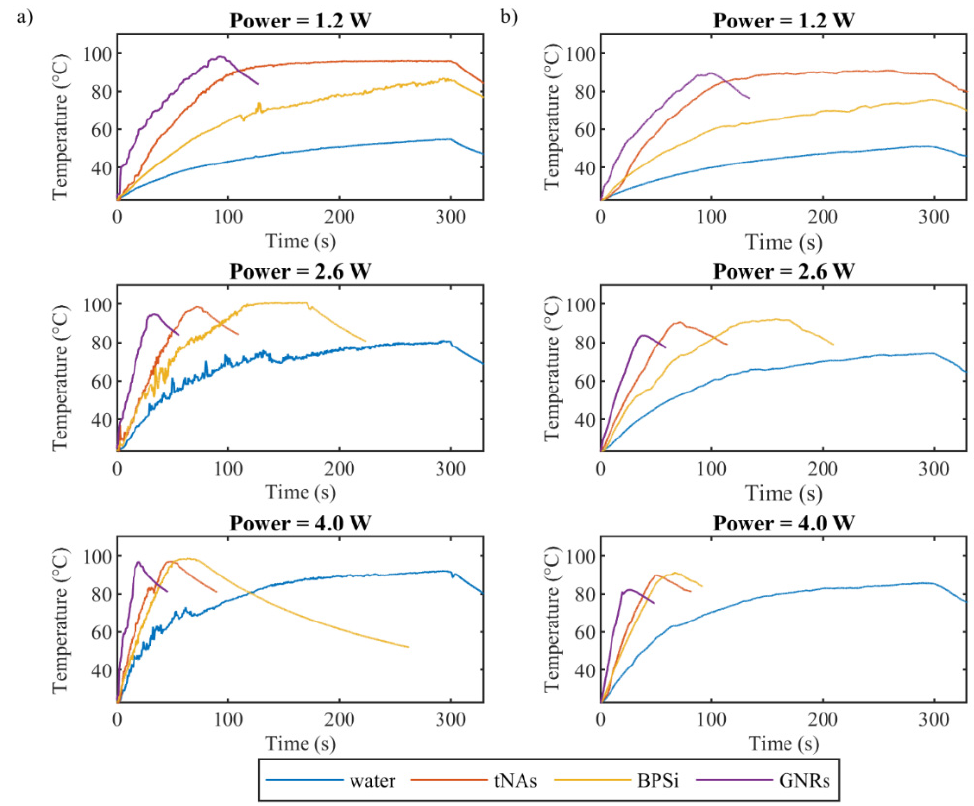
Figure 3. Maximum temperature in the water phantom with and without NPs measured by ( a ) FBG sensor inside the phantom and ( b ) thermal camera on the surface of phantom, during the irradiation 808 nm laser beam with three powers of 1.2, 2.6 and 4 W.